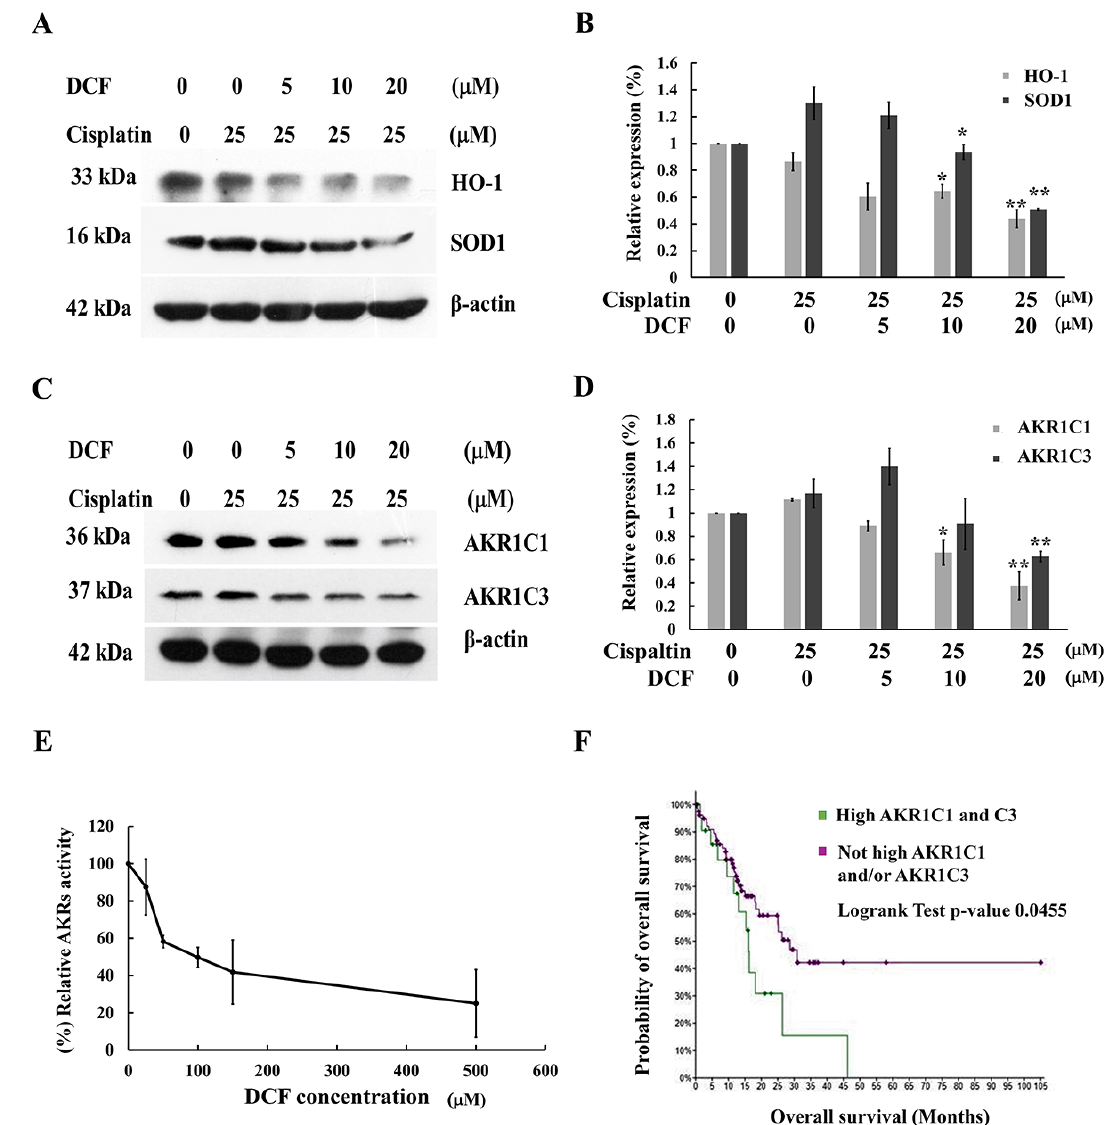
Figure 4. DCF modulated Nrf2 downstream target genes in cisplatin-treated KATO/DDP cells. ( A ) KATO/DDP cells were treated with cisplatin alone or combined with DCF 5, 10 or 20 μM for 24 h , and the expression of HO-1 and SOD1 were determined by Western blot analysis. ( B ) Quantitative representation of band density for HO-1 and SOD1. ( C ) The expression of AKR1C1 and 1C3 were evaluated by Western blot analysis, and ( D ) densitometric and statistical analysis of protein quan- tification data are presented as histogram. ( E ) The effect of DCF on AKRs activity was measured by using aldose reductase activity kit. ( F ) The overall survival curve comparing the gastric cancer pa- tients between high AKR1C1 and 1C3 mRNA expression and not high AKR1C1 and/or 1C3 mRNA expression by using cBioPortal for cancer genomics. All experiments were performed at least three times. * Represented p < 0.05, while ** represented p < 0.01 as compared to the cisplatin alone. DCF = Diclofenac, AKRs = Aldoketoreductases.